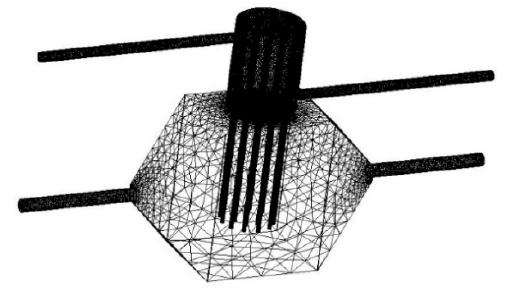
Figure 2. Wireframe of mesh generated.